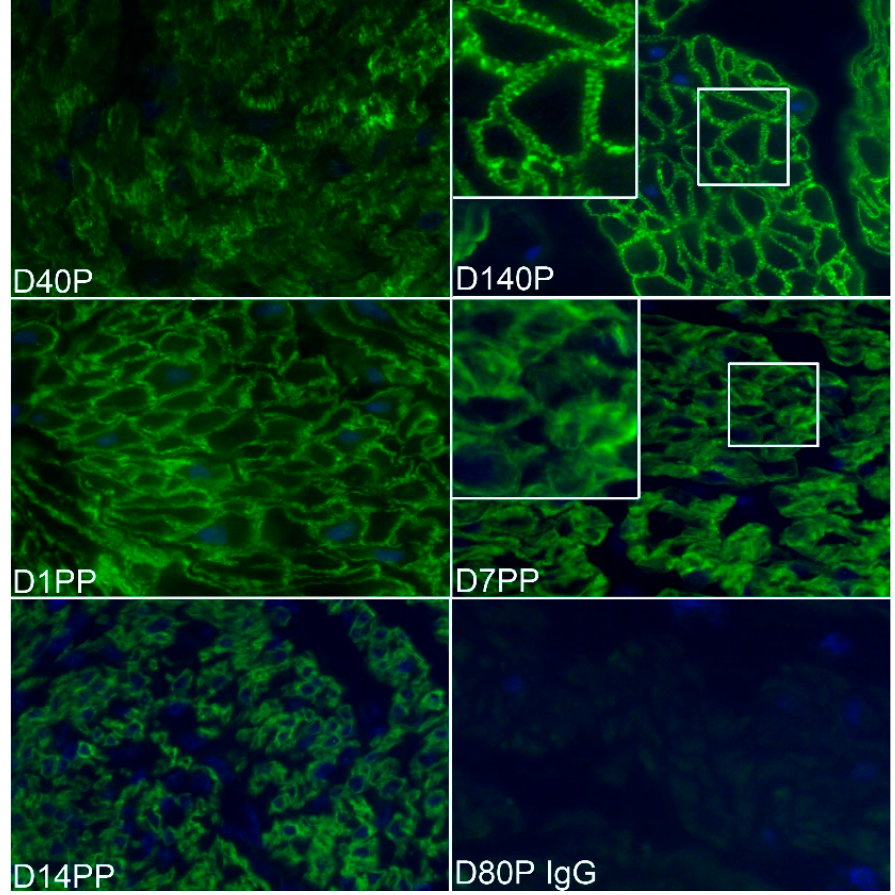
Figure 3. Immunostaining for the alpha 5 integrin (ITGA5) in the myometrium of ewes on Days (D) 40 and 140 of pregnancy (P) and Days 1, 7, and 14 postpartum (PP). Note the linear strands of IACs that appear as regularly distributed spots at the myometrial cell surface present in some cells on Day 40, which are present and highly ordered on all myometrial cells by Day 140 of pregnancy. These highly ordered IACs are no longer present in the myometrium of postpartum ewes. For comparison, insets provide surface views of myometrial cells during late pregnancy and postpartum. An irrelevant rabbit IgG served as a negative control. The width of each field is 140 µm; the inset is 25 µm.